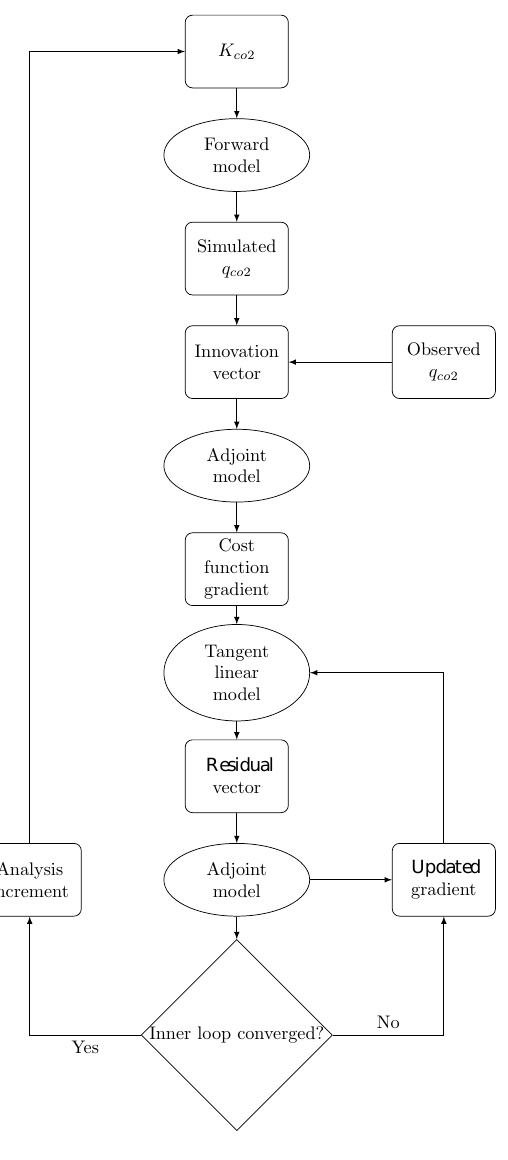
Figure 2. Diagram of Lanczos-CG-based incremental optimization implemented for WRF-CO2